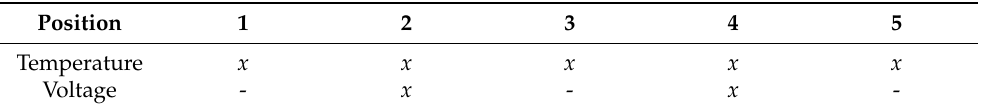
Table 1. Temperature and voltage measurements with regular setup (i.e., without Carbon Fiber- Reinforced Carbon (CFRC) plates).